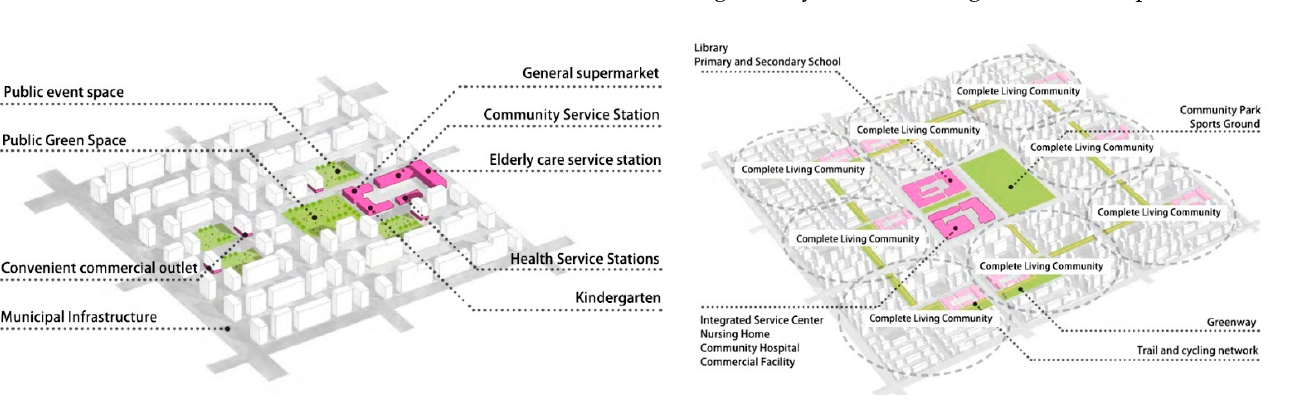
Figure 4. Complete residential community and 15-min living circle (Based on the Complete Residential Community Guide ).